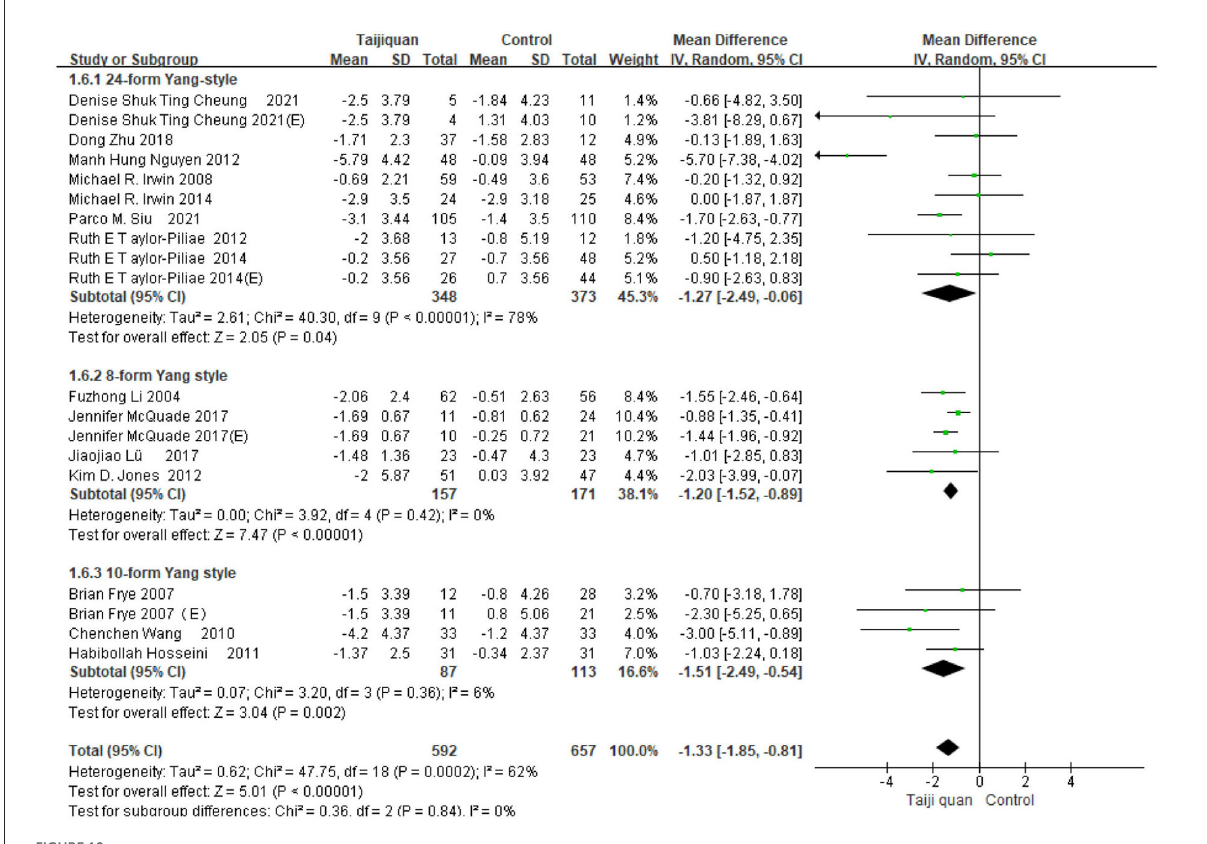
FIGURE10 Subgroups of different forms of Taijiquan analyzed forest